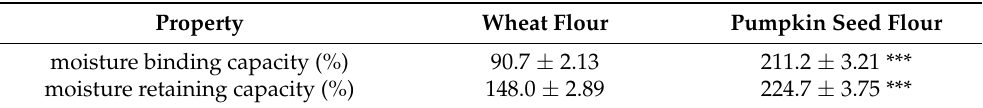
Table 3. Functional and technological properties of wheat flour and pumpkin seed flour. Data